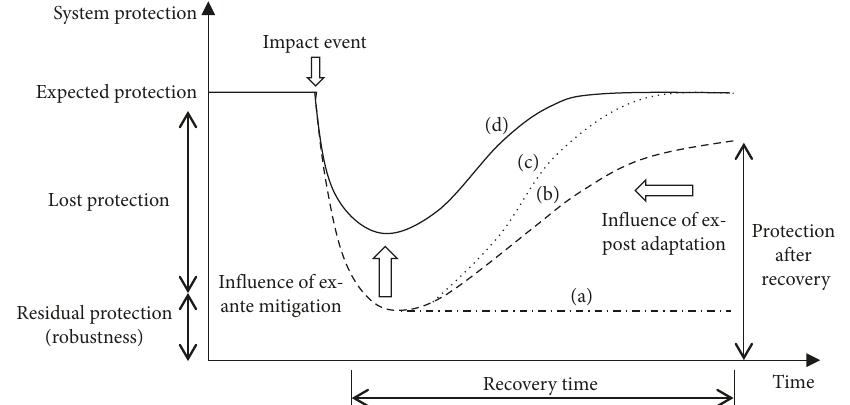
Figure 3: The resilience of buffer